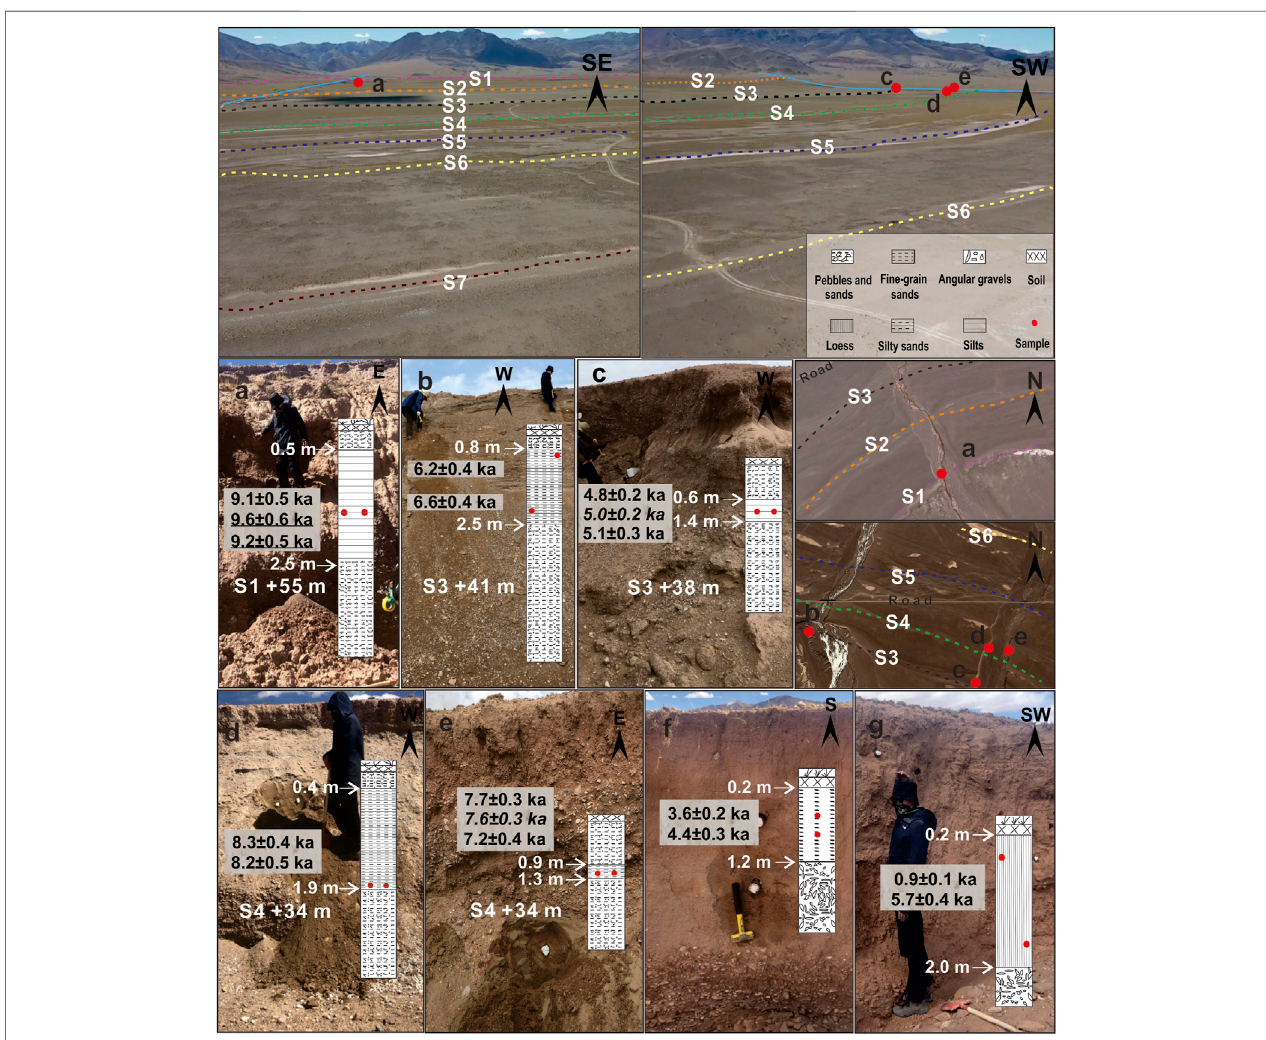
FIGURE 2 | Field photos, sampling pro fi les, and OSL ages. The fi eldwork was carried out in 2019 and 2021. Note that ages in italics refer to pIRIR 225 ° C results from K-feldspar, while underlined ages refer to fi ne-grained quartz (4 – 11 μ m) results.